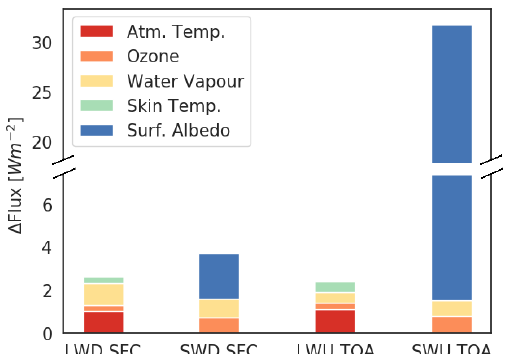
Figure 6. Results of the sensitivity analysis visualized as stacked bar chart of the absolute change in CS fluxes in response to per- turbations of various input parameters of the T-CARS simulation. Changes are shown for the downward LW (LWD) and SW (SWD) fluxes at the surface (SFC), and the upward LW (LWU) and SW (SWU) fluxes at the top of the atmosphere (TOA), in response to changes in atmospheric temperature, ozone and water vapour col- umn, skin temperature and surface